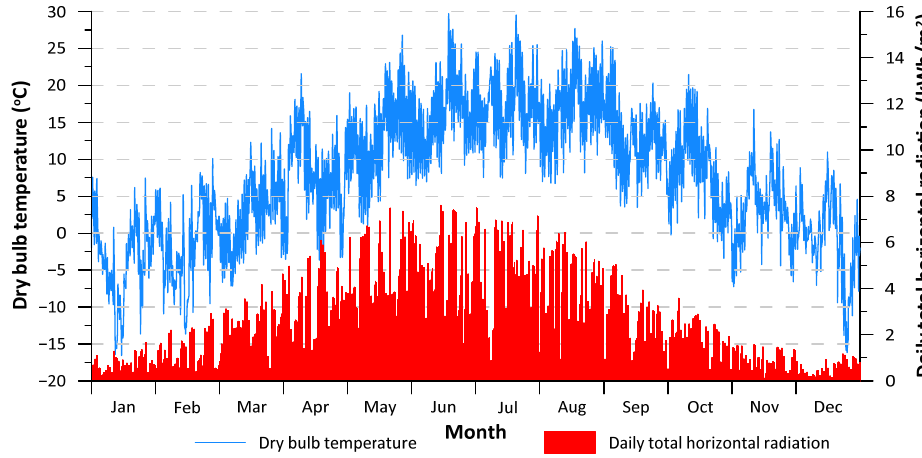
Figure 1. Meteorological data from Meteonorn TM2 database for a typical year in Krakow.